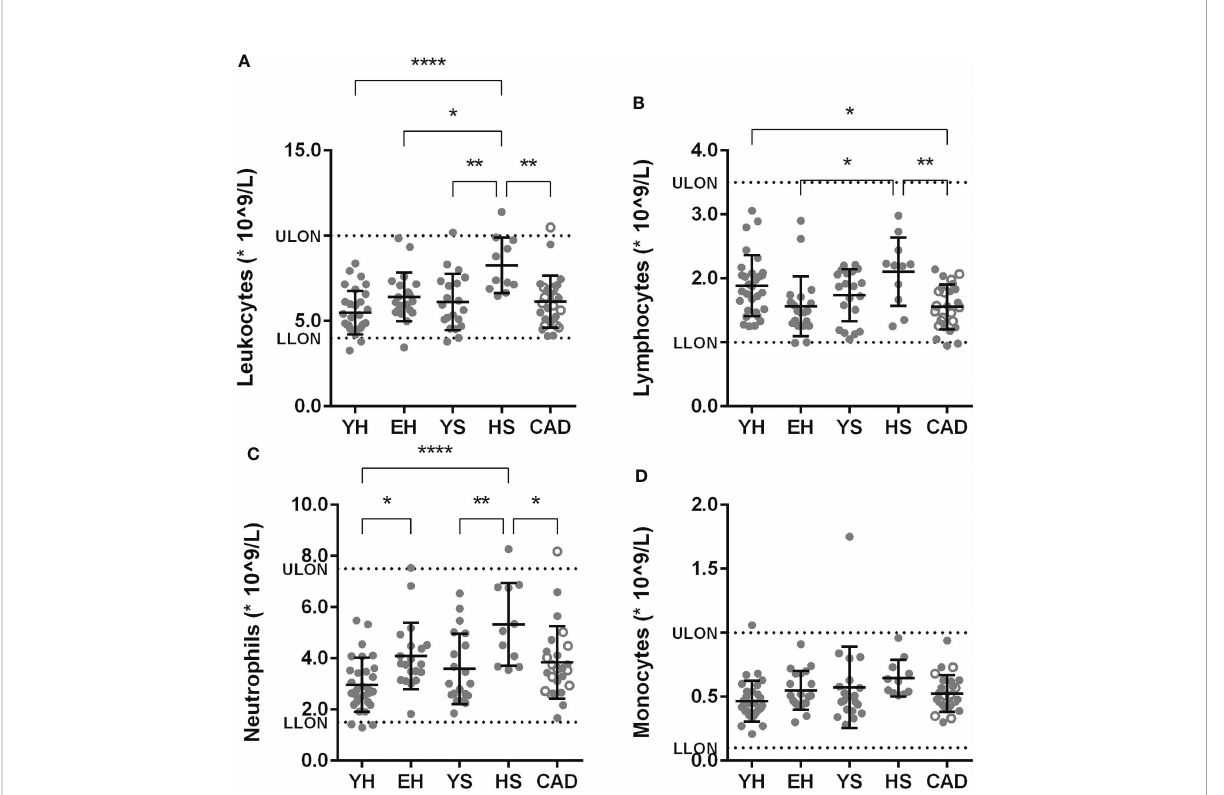
FIGURE 2 Effect of ageing and smoking on absolute circulating leukocytes. Amount of leukocytes (A) , lymphocytes (B) , neutrophils (C) , monocytes (D) in circulation as measured by sysmex. Mean ± SD are shown. LLON, lower limit of normal; ULON, upper limit of normal; YH, young healthy; EH, elderly healthy; YS, young smoker; HS, heavy smoker; CAD, coronary artery disease patient. Open circles in the CAD group represent smokers. Statistics was performed using one-way ANOVA with Dunnett ’ s post hoc test, means were compared to the YH group. P values ≤ 0.05 are considered signi fi cant. * p ≤ 0.05, ** p ≤ 0.005, **** p ≤